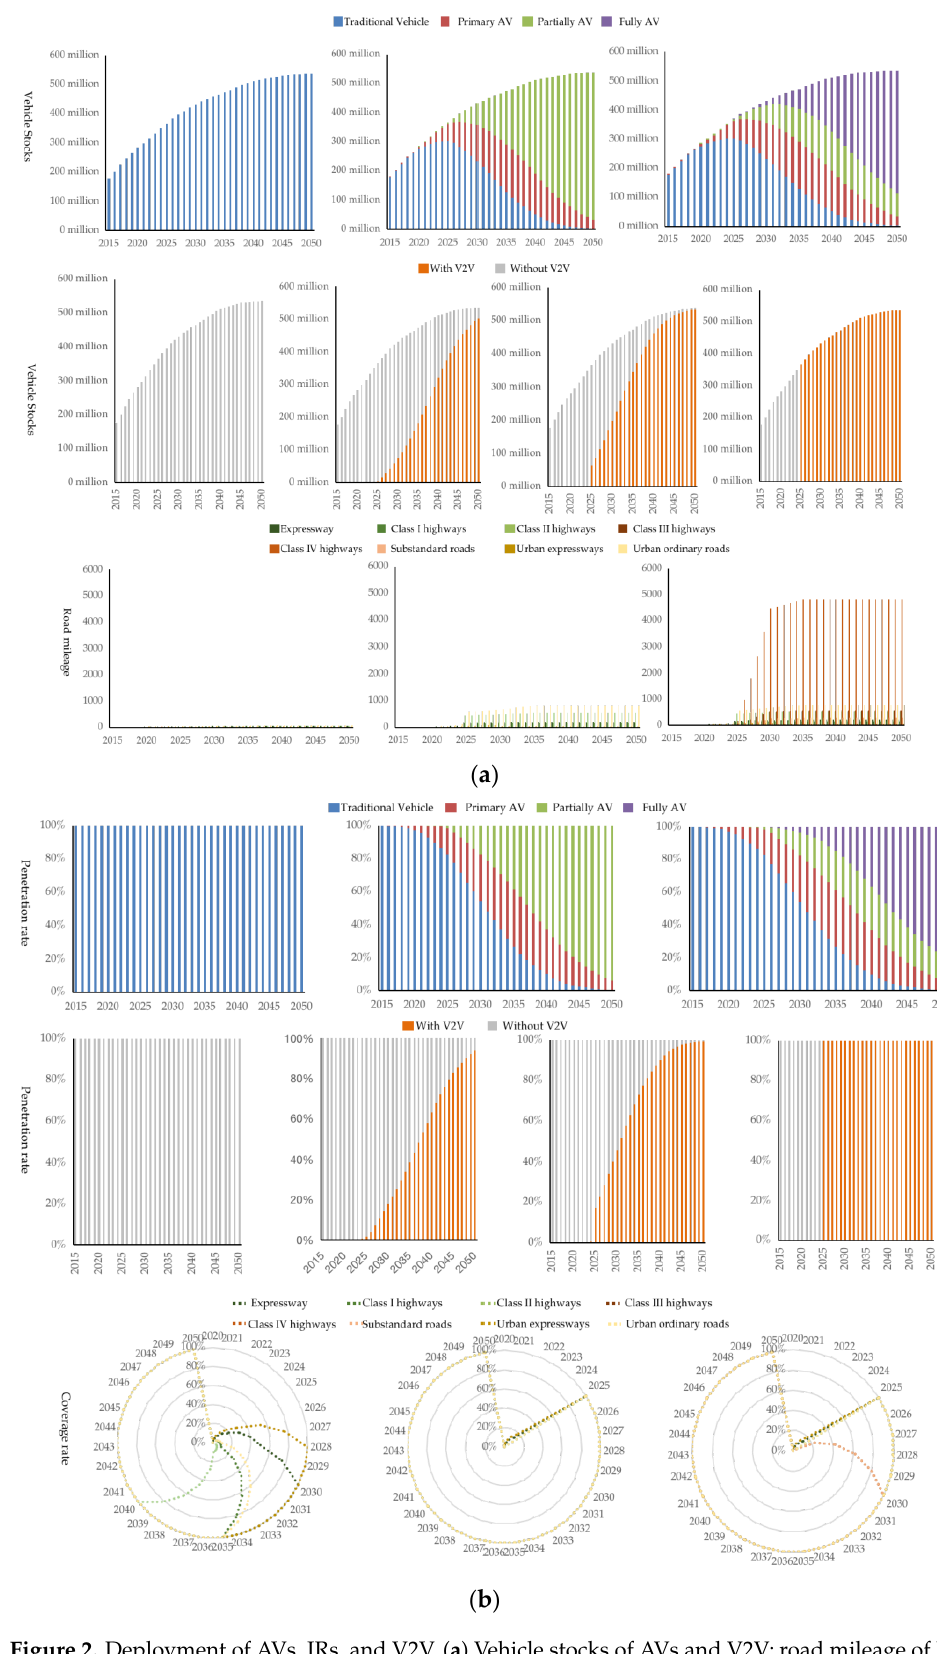
Figure 2. Deployment of AVs, IRs, and V2V. ( a ) Vehicle stocks of AVs and V2V; road mileage of IRs in China from 2015 to 2050; ( b ) Proportion of AVs and V2V in the vehicle stocks; the proportion of IRs in different road types from 2015 to 2050.